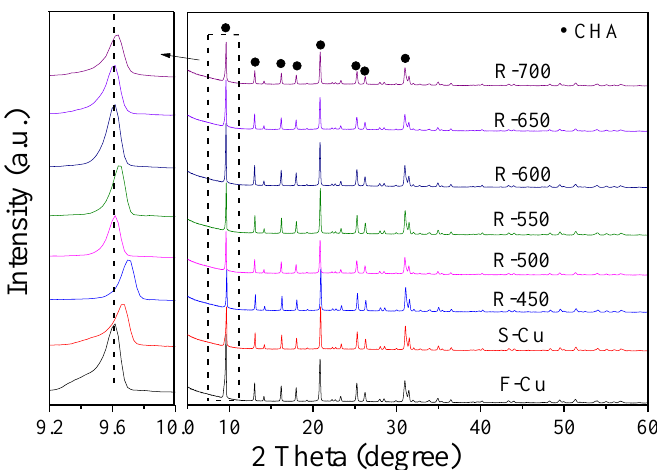
Figure 1. XRD profiles of Cu-SSZ-13 catalysts in fresh, sulfated and regenerated states.